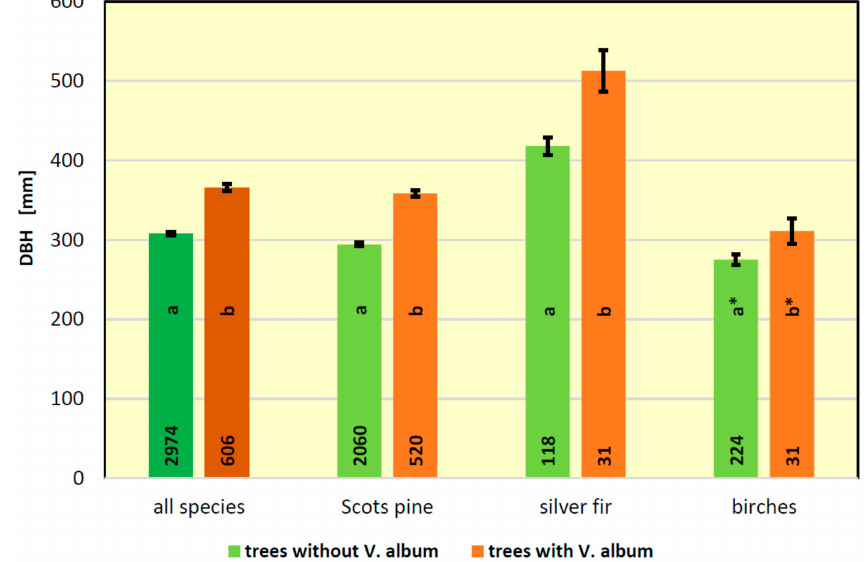
Figure 9. The average DBH of trees attacked by V . album and free from the parasite on the plots with mistletoe present and the results of the Student’s t -test where “ab” denotes a significant di ff erence between means ( p < 0.05) and “a*b*” denotes slight significance ( p =